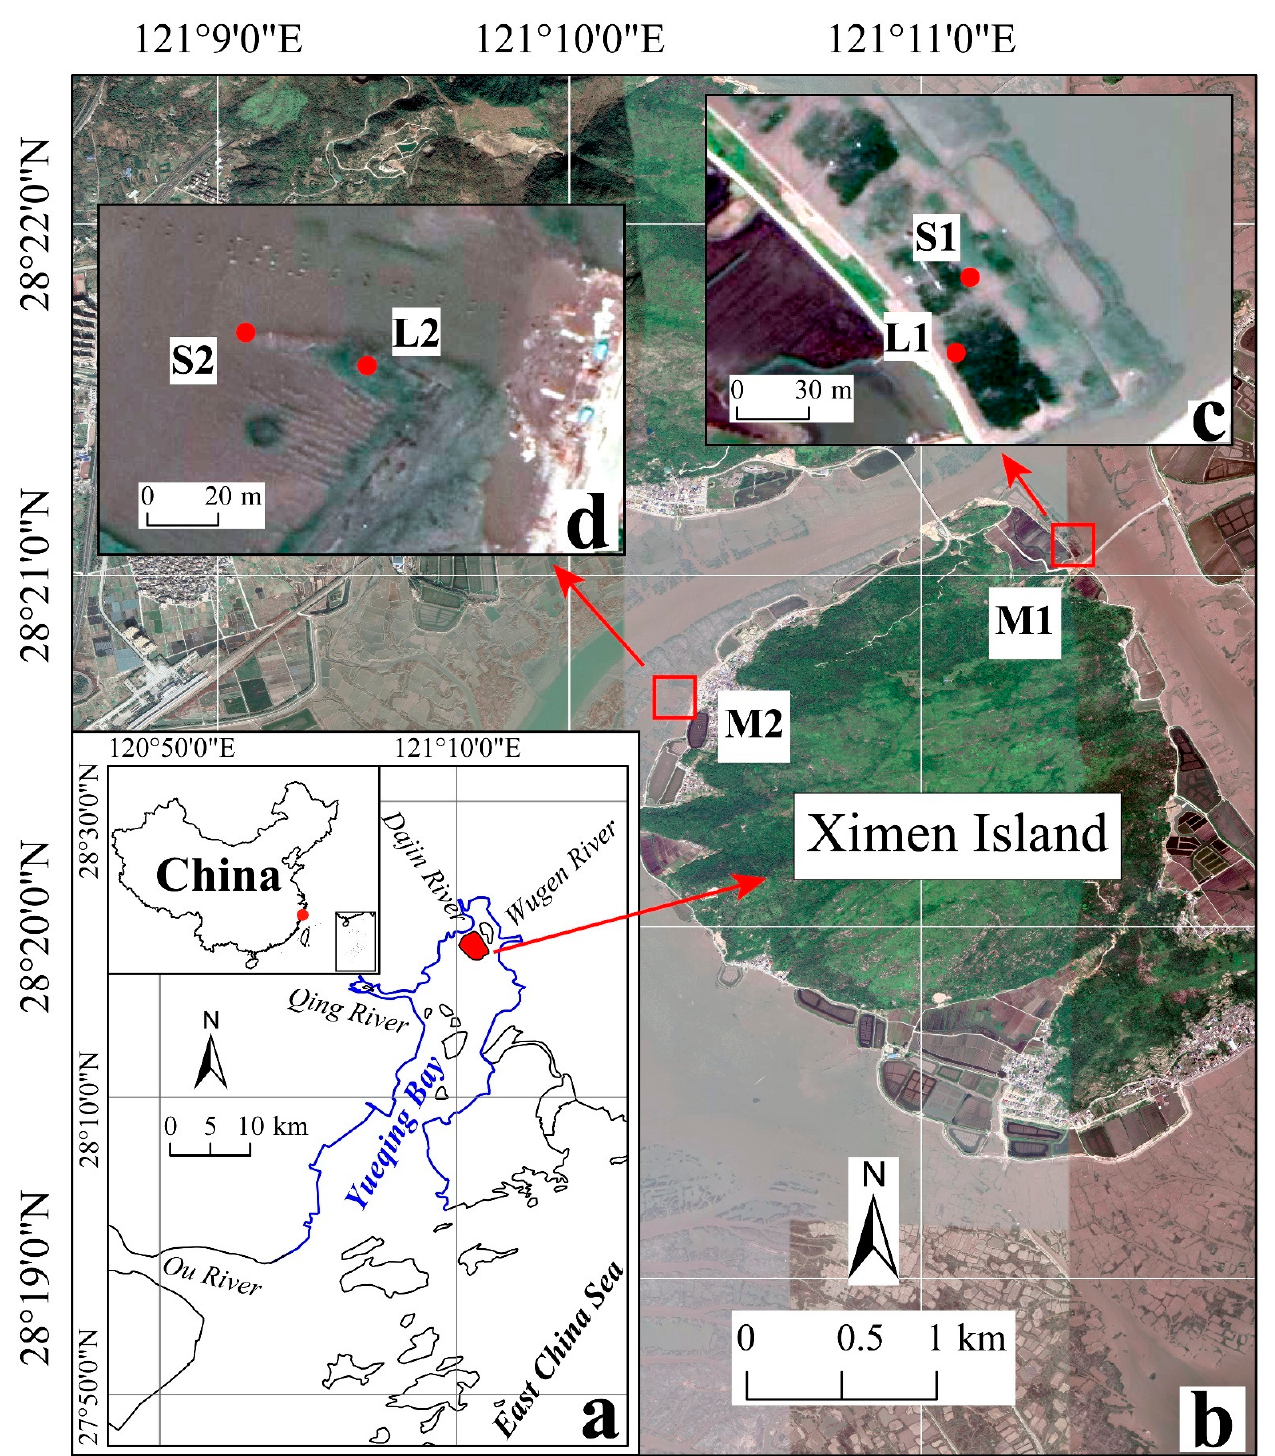
Figure 1. Locations of ( a ) Ximen Island (red area) and Yueqing Bay (blue lined area) in southeastern China; ( b ) two mangrove systems, M1 and M2, on Ximen Island; ( c ) locations of two sediment cores along mangrove M1, L1 and S1; and ( d ) locations of two sediment cores along mangrove M2, L2 and